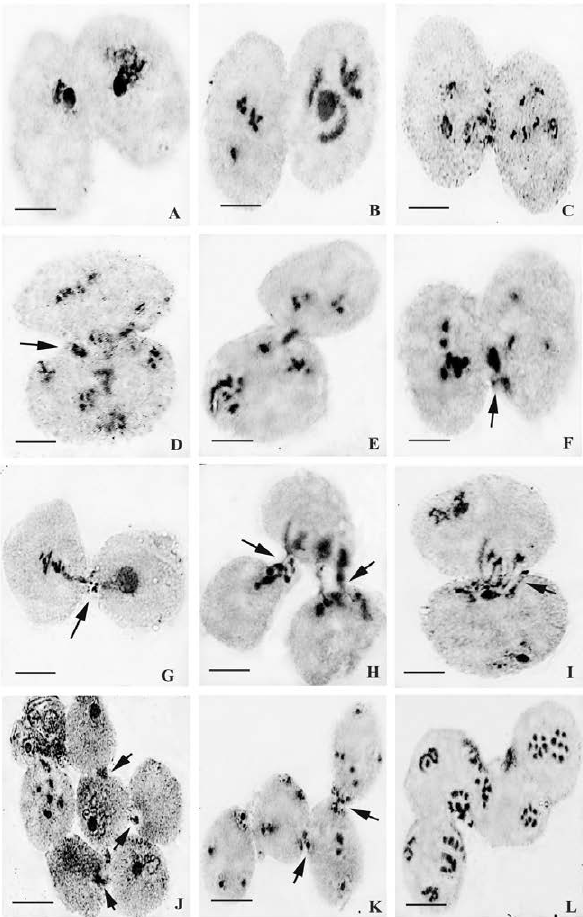
Fig. 1. Cytomixis via direct cell fusion (A-F) where A: Direct cell fusion at Diplotene; B: Cell fusion between Prophase 1 and meta- phase I; C: Chromatin transfer between two PMCs; D: Horizontal transfer of chromosomes where one PMC is chromatin deficient; E: A chromosomal fragment in the transition phase; F: Migrating chromatin pushed towards periphery as sticky chromatin